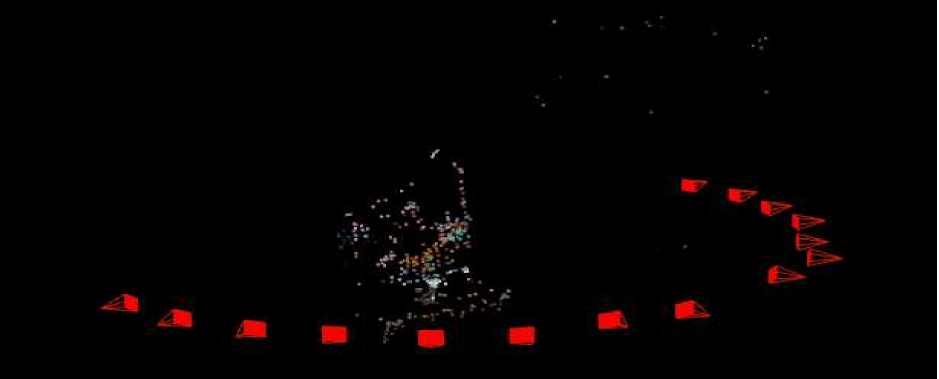
Figure 21. Successive camera poses (the vertex of the red tetrahedron indicates the camera optical center position while the complete tetrahedron represents the camera orientation). This figure also shows the sparse 3D point cloud determined by